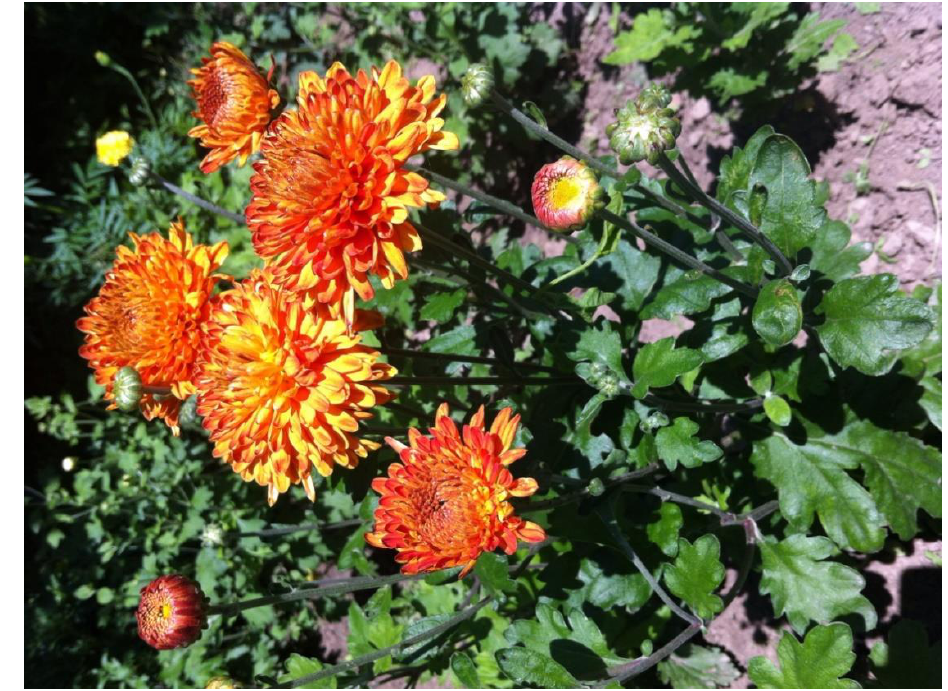
Fig. 1. Chrysanthemum×hortorum Bailey, Pectoral